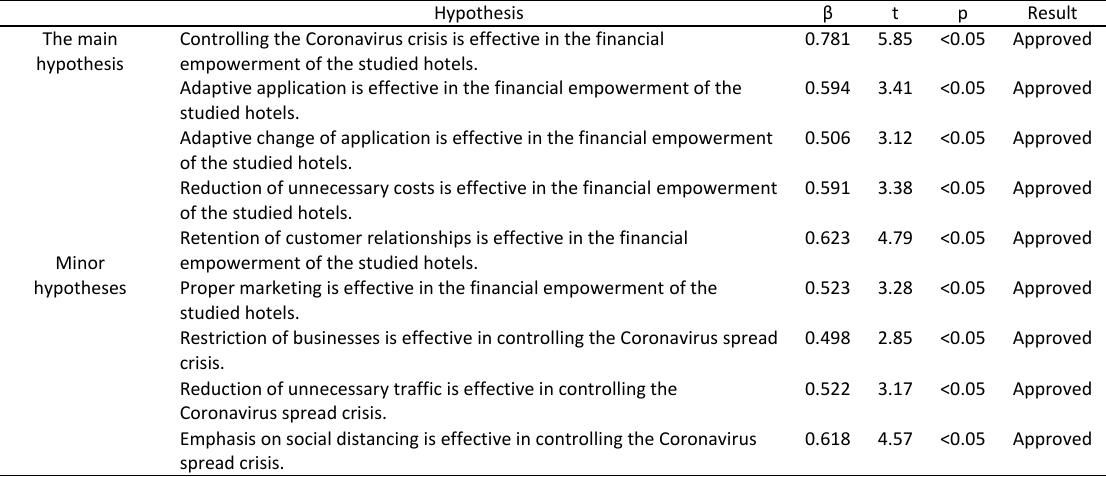
Table 8: The results of testing the hypotheses Hypothesis β p